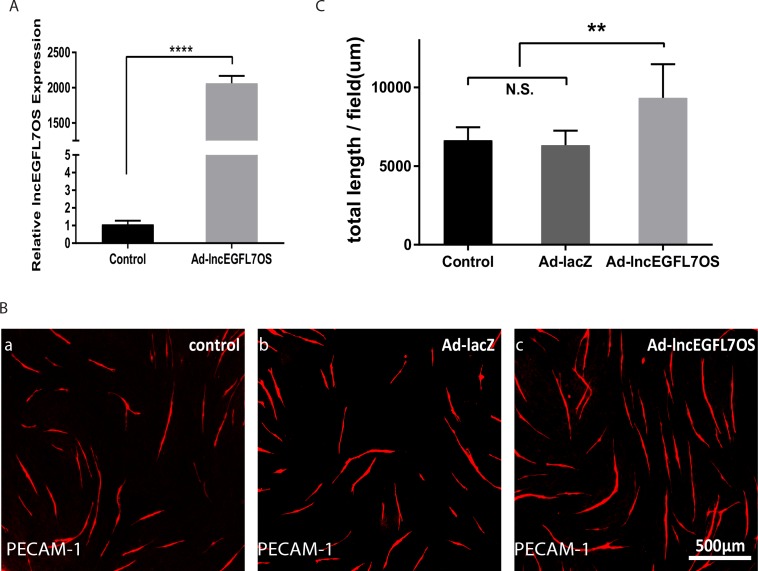
Effect of lncEGFL7OS oeverexpression in angiogenesis.(A) qRT-PCR showing overexpression of lncEGFL7OS in ECs infected with lncEGFL7OS expressing adenovirus. LacZ expression virus was used as control; (B) Representative images showing enhanced angiogenesis at 7 days after lncEGFL7OS overexpression in an EC-fibroblast co-culture assay. LacZ or noninfection samples were used as controls. Scale bar equals to 500 µm; (C) Quantification of tube length/area in B (n = 3). **p<0.01.10.7554/eLife.40470.021Figure 4—figure supplement 2—source data 1.Figure 4—figure supplement 2 source data.